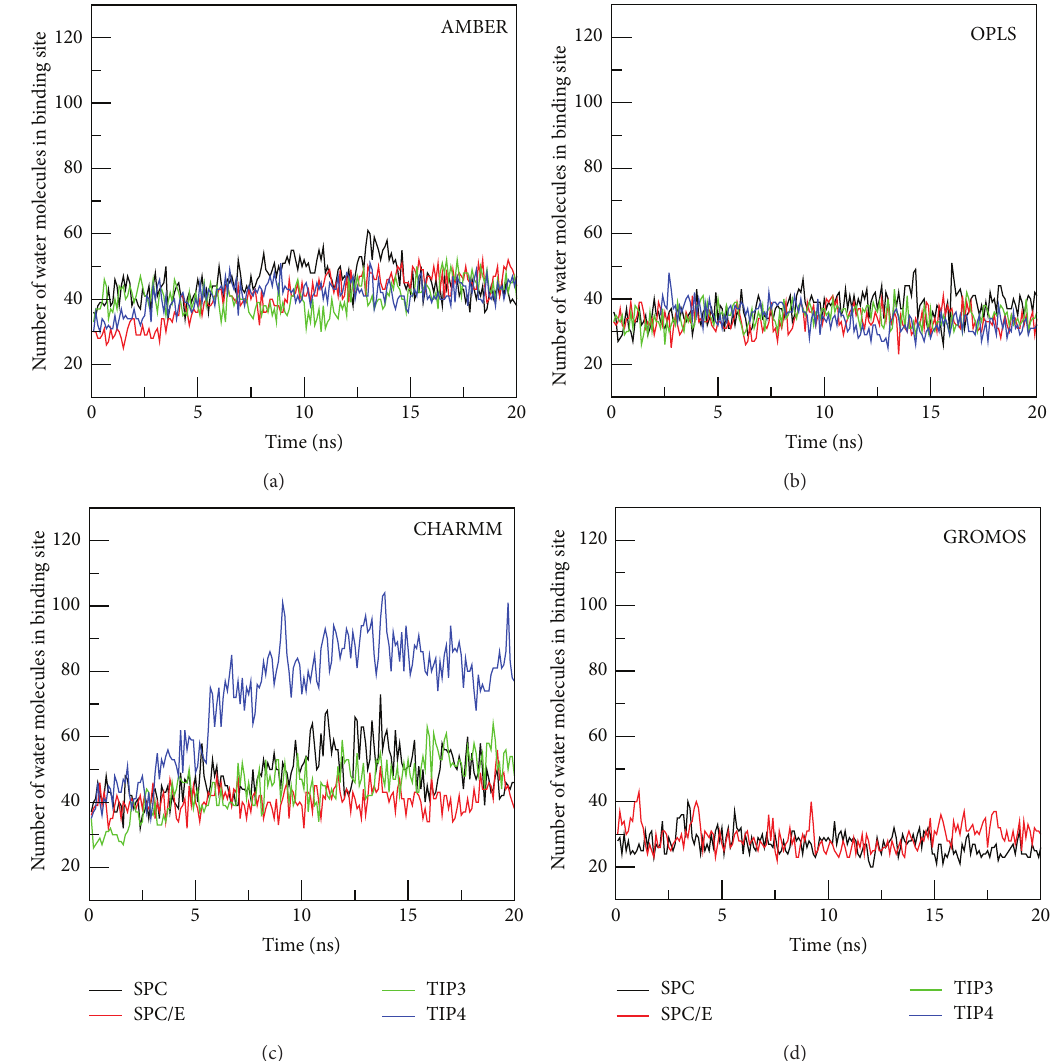
Figure 7: Time dependence of the number of water molecules inside the binding